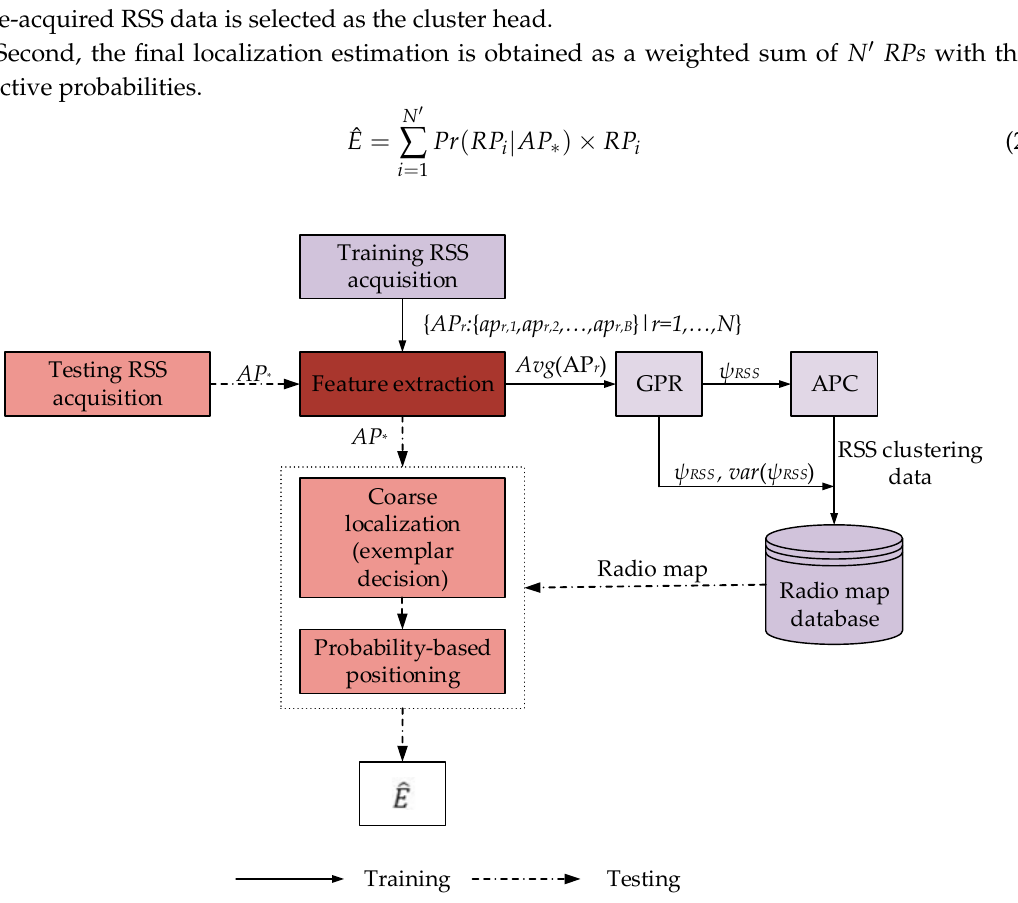
Figure 1. Framework of the proposed APC-based fingerprinting localization adopting GPR.